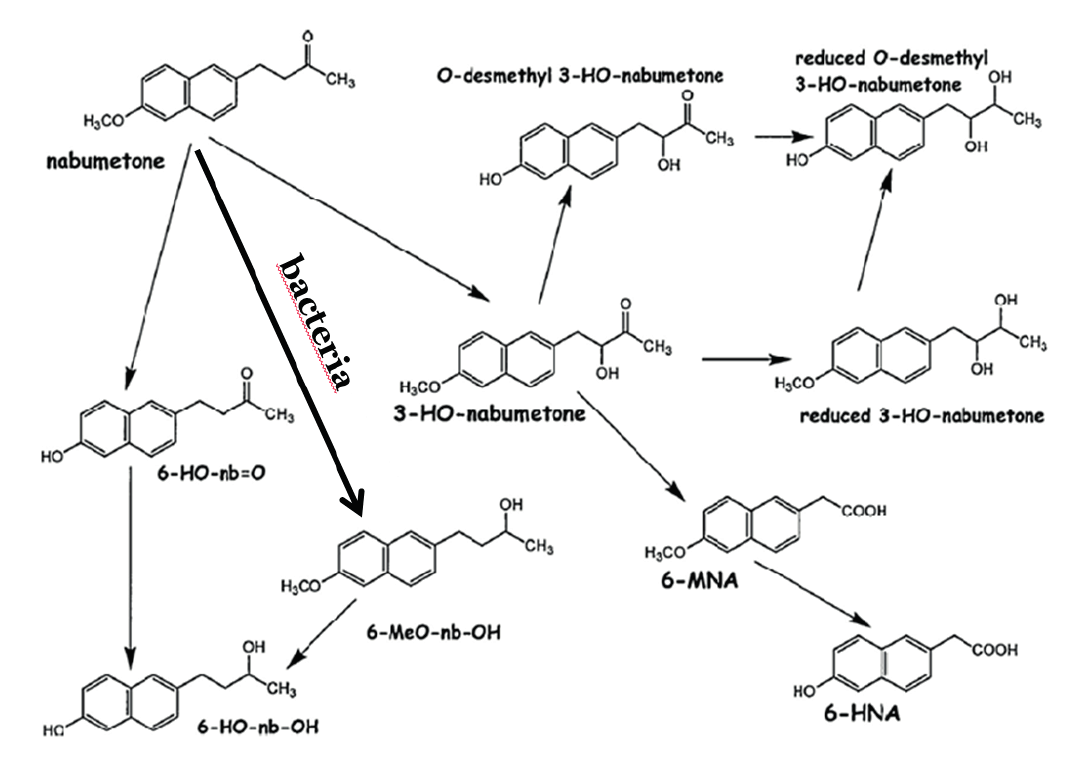
Fig. 3. Metabolism of nabumetone (adapted from Nobilis et al., 2013 78 ). Nabumetone is in vitro reduced by commensal intestinal bacteria into pharmacologically inactive metabolite 4-(6-methoxy-2-naphthyl)-butan-2-ol (reduced nabumetone). These results indicate that gut microbiota may cause lower absorbtion of nabumetone and thus, lower its bioavailability. Metabolites of nabumetone: Nabumetone: 4-(6-methoxy-2-naphthyl)-2-butanone (c (c H o ); 6-mNa: 6-methoxy-2-naphthylacetic acid (c 12 10 3 6-Ho-nb=o: 4-(6-hydroxy-2-naphthyl)-butan-2-one